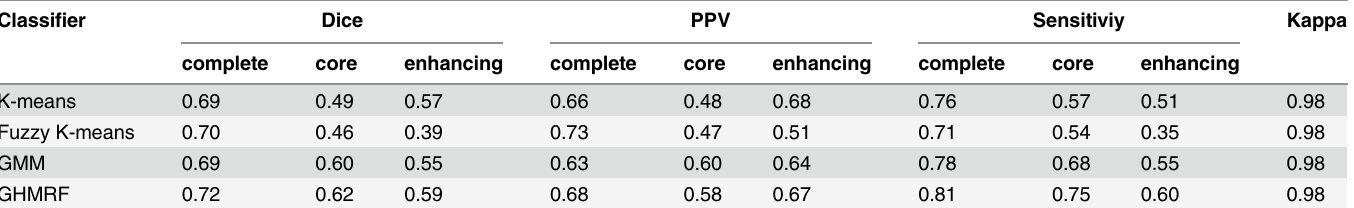
Table 1. Summary of average results obtained by the different unsupervised algorithms in combination with the proposed preprocess and post- process over the BRATS 2013 Test set. Classi fi er Dice complete K-means 0.69 Fuzzy K-means